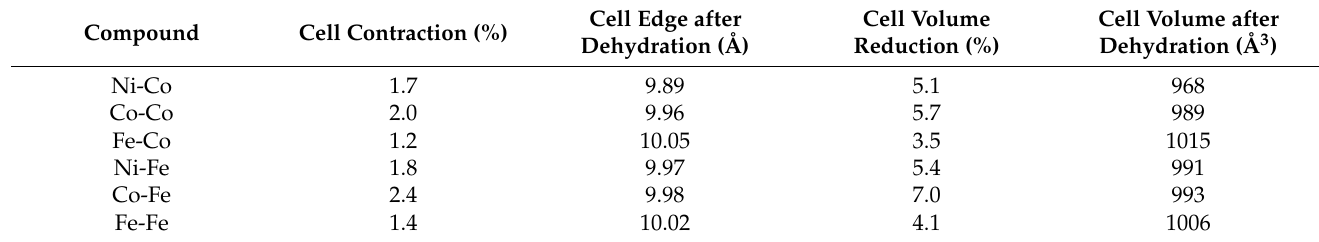
Table 4. Effect of dehydration over hexacyanometallate(III) cell dimensions.